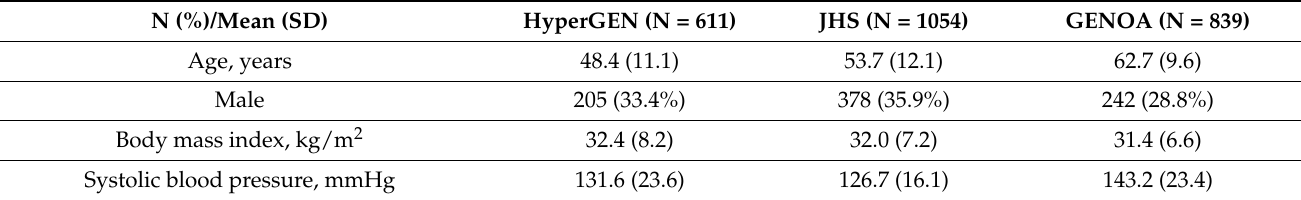
Table 1. Characteristics of African Americans in HyperGEN, JHS, and